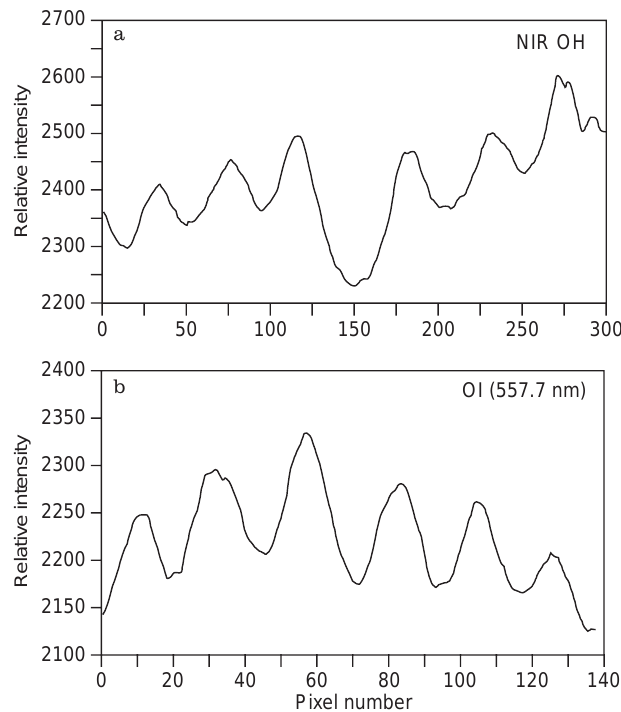
Fig. 2. Scans along the white lines across the airglow images in